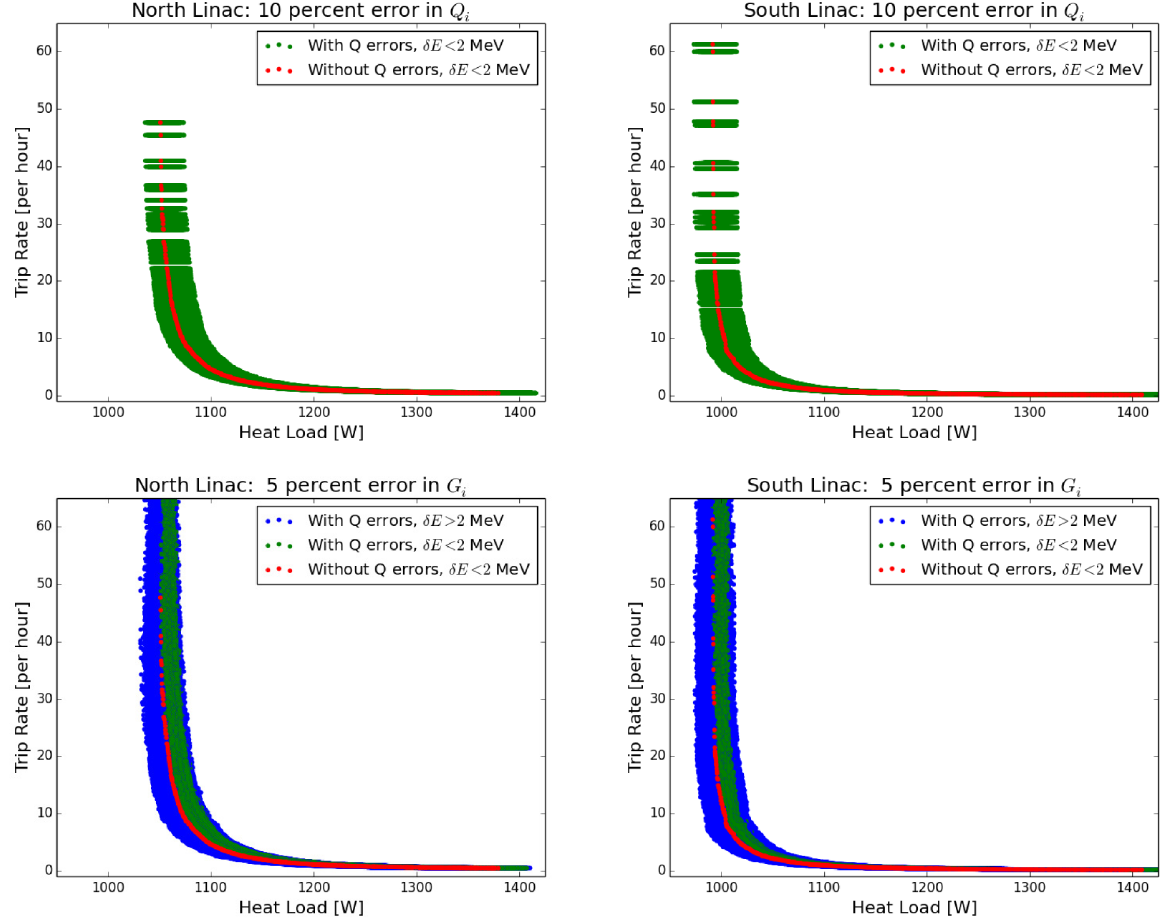
FIG. 9. Sensitivity on the Pareto-optimal front to a 10% measurement error in the cavity quality factor Q i for the North (top left) and South linacs (top right) and a 5% measurement error in gradients G i for the North (bottom left) and South linacs (bottom right). The blue (energy constraint not satisfied) and green (energy constraint satisfied) represent 10000 different machine configurations with measurement errors artificially introduced. The (unperturbed) Pareto-optimal fronts (red) are the same as those in Figs. 5 and 6, generated with 512 individuals evolved for 16000